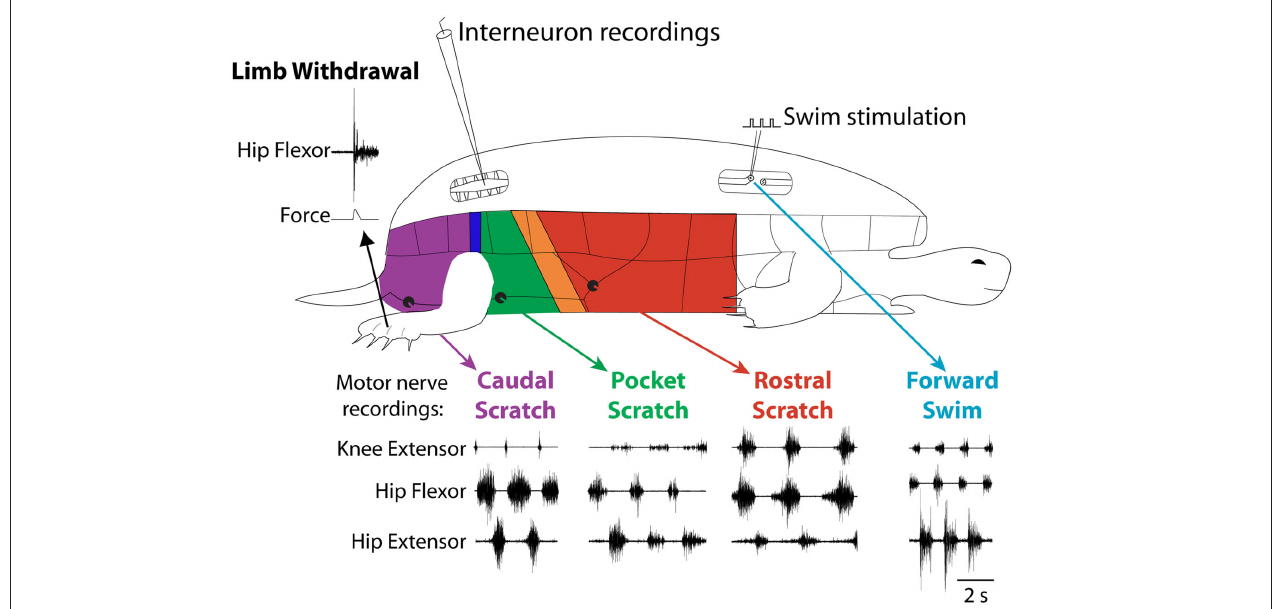
regions can elicit either of two forms or a blend of the two. Forward swimming is elicited by electrical stimulation in the contralateral lateral funiculus of a mid-body segment. Limb withdrawal is elicited by a tap to the dorsal